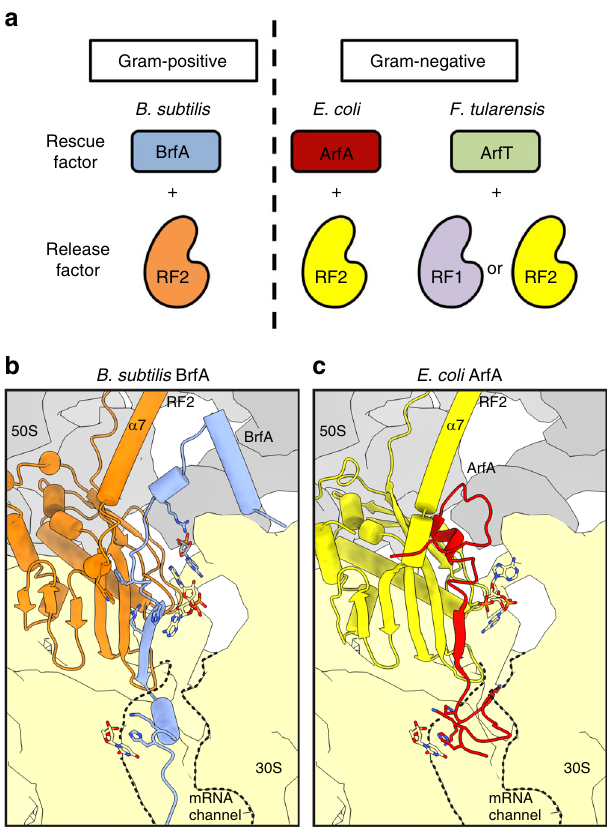
Fig. 6 RF-dependent ribosome rescue factors in bacteria. a Independent evolution of the RF-dependent ribosome rescue factors. ArfA and BrfA are unrelated in their amino acid sequences despite the same partner (RF2) speci fi city. ArfT forms a still distinct group and cooperates with either of RF1 or RF2. They show narrow distributions among bacterial species. b , c A schematic model highlighting the similarities and differences between ( b ) BrfA- and ( c ) ArfA-mediated ribosome rescue